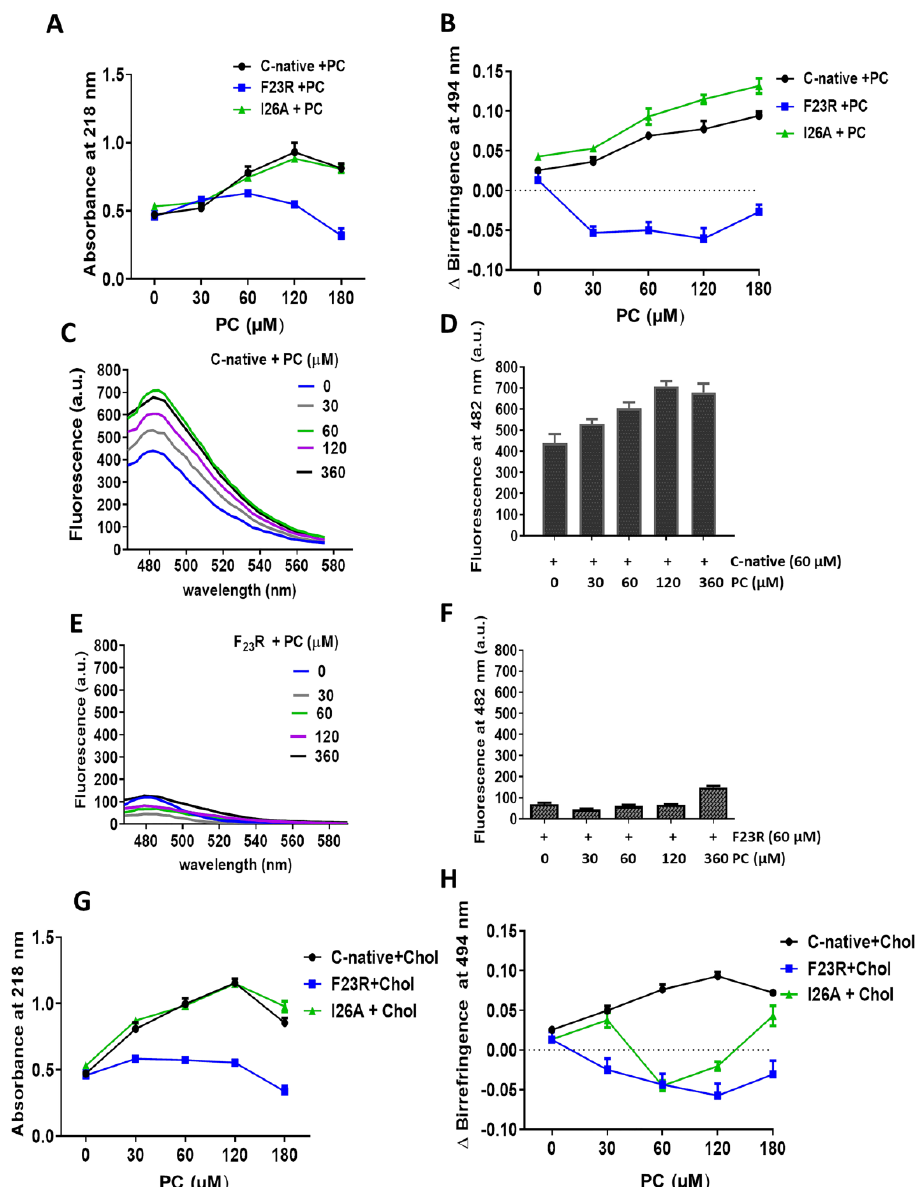
Figure 3. Effect of zwitterionic L- α -phosphatidylcholine-small unilamellar vesicles (PC-SUVs) on the secondary structure of IAPP-peptides. ( A ) Peptide bond absorbance of the C-native segment, F 23 R, and I 26 A under incubation with PC-SUVs. ( B ) Peptide characterization by birefringence with Congo red assay. ( C ) Interaction of the C-native segment under increasing concentrations of PC-vesicles evaluated by ThT assay. ( D ) Values of ThT-fluorescence emission at 482 nm. ( E ) Interaction between F 23 R under increasing concentrations of PC. ( F ) Values of ThT-fluorescence emission at 482 nm. Characterization of the C-native segment, F 23 R, and I 26 A under the incubation of SUVs composed of PC and cholesterol (Chol) through peptide bond absorbance at 218 nm ( G ) and Congo red assay ( H ).